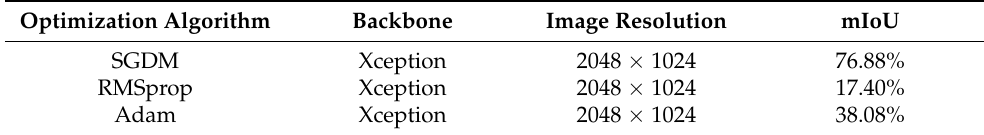
Table 4. Comparison of training results with different optimization algorithms.